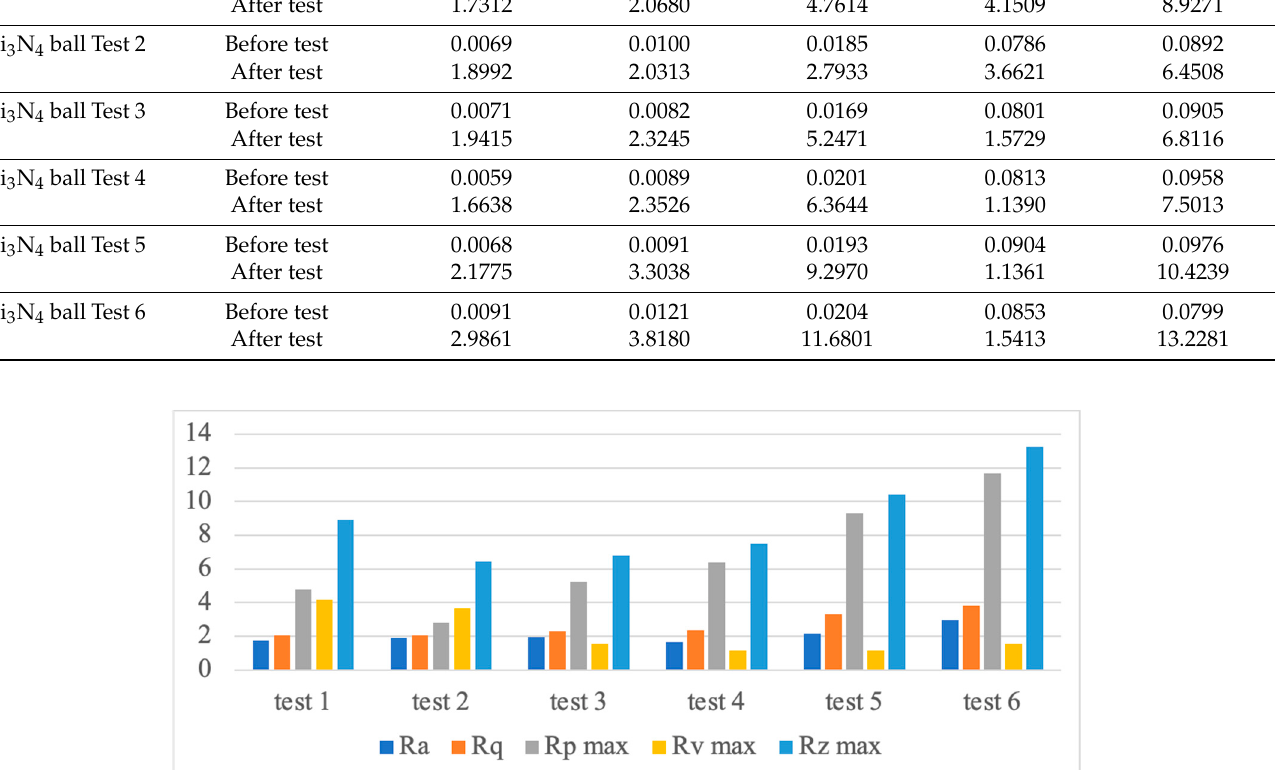
Figure 7. Surface roughness of balls after testing.